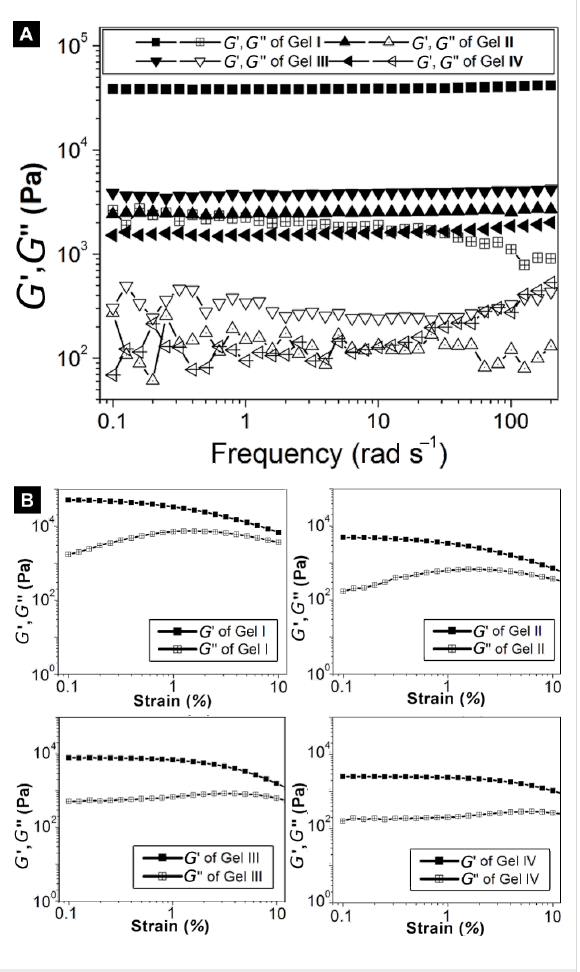
Figure 3: (A) Frequency dependence of dynamic storage modulus ( G ’) and loss modulus ( G ”) of gels I to IV at 1.0 wt % concentration. (B) Dynamic storage modulus ( G ’) and loss modulus ( G ’’) versus strain for the gels I to IV .